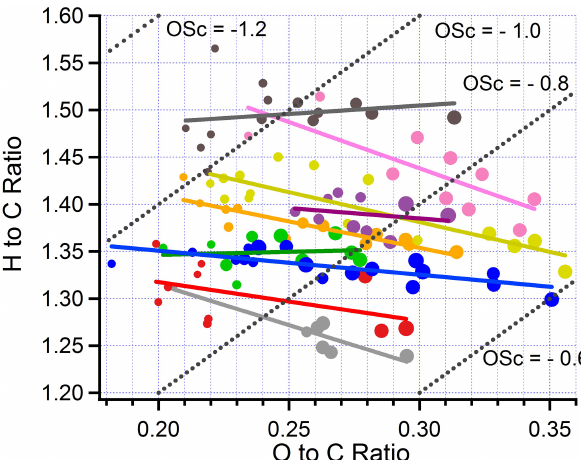
Figure 13. Van Krevelen diagram. Size of symbol linearly propor- tional to photochemical age. Dotted lines show H : C and O : C cor- responding to labelled values of carbon oxidation state (OSc). Color code for flights same as in Fig. 11. Solid lines are linear least squares fit to data points in corresponding